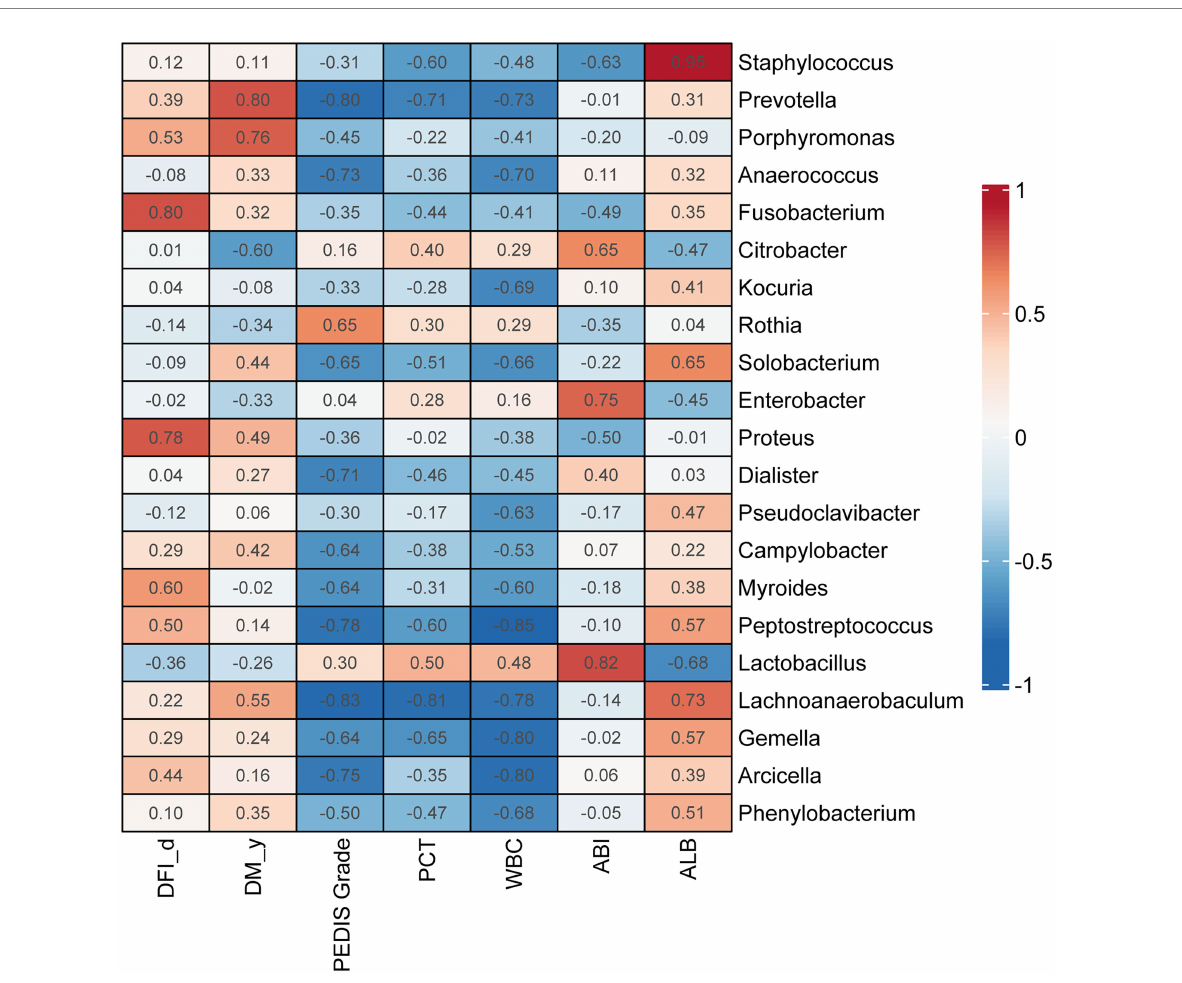
FIGURE 6 Correlations between genera in DFI wounds and clinical parameters. Correlation coefficients are marked in the heatmap. Red indicates a positive correlation with each index, and blue indicates a negative correlation with each index. DM _y: duration of diabetes (years), DFI _d: duration of diabetic foot infection